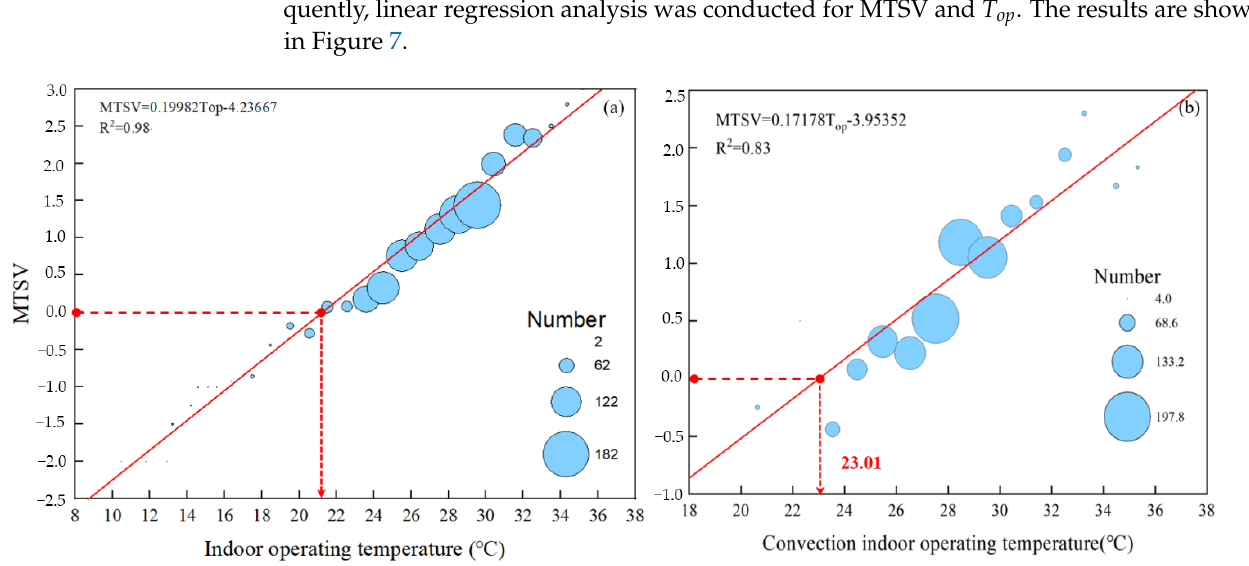
11 of 20 Figure 6. The thermal sensation vote ’ s thermal preference distribution: ( a ) radiant and ( b ) convective heating. 3.4. Thermal Comfort Analysis The thermal comfort of the individuals was further examined in this study under